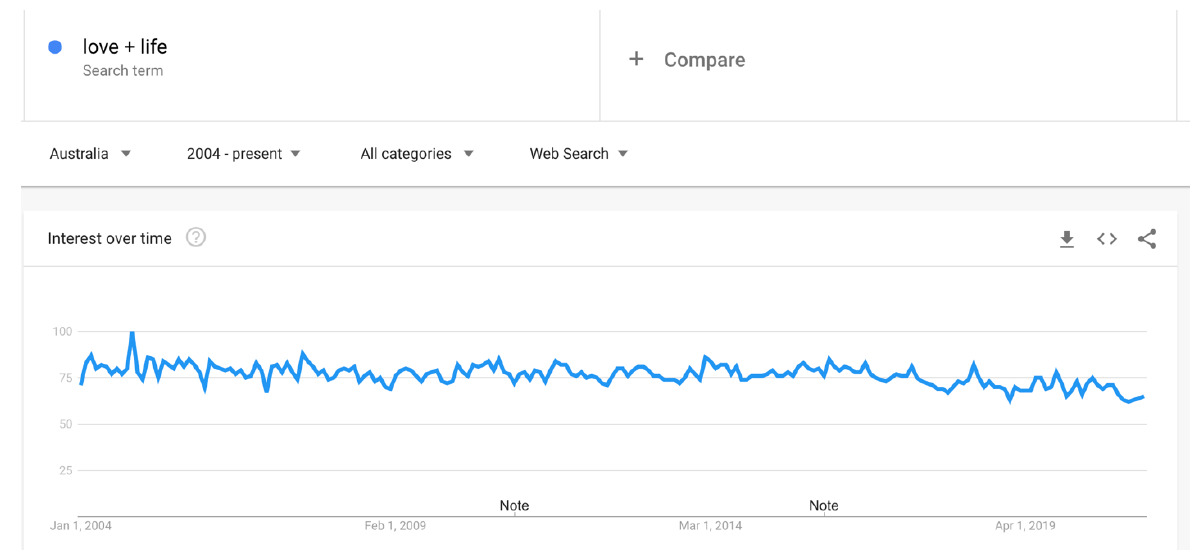
Figure 1: Combined Benchmark Search Query Index for ‘love + life’ (31 March 2021) Data source: Google Trends (https://www.google.com/trends)